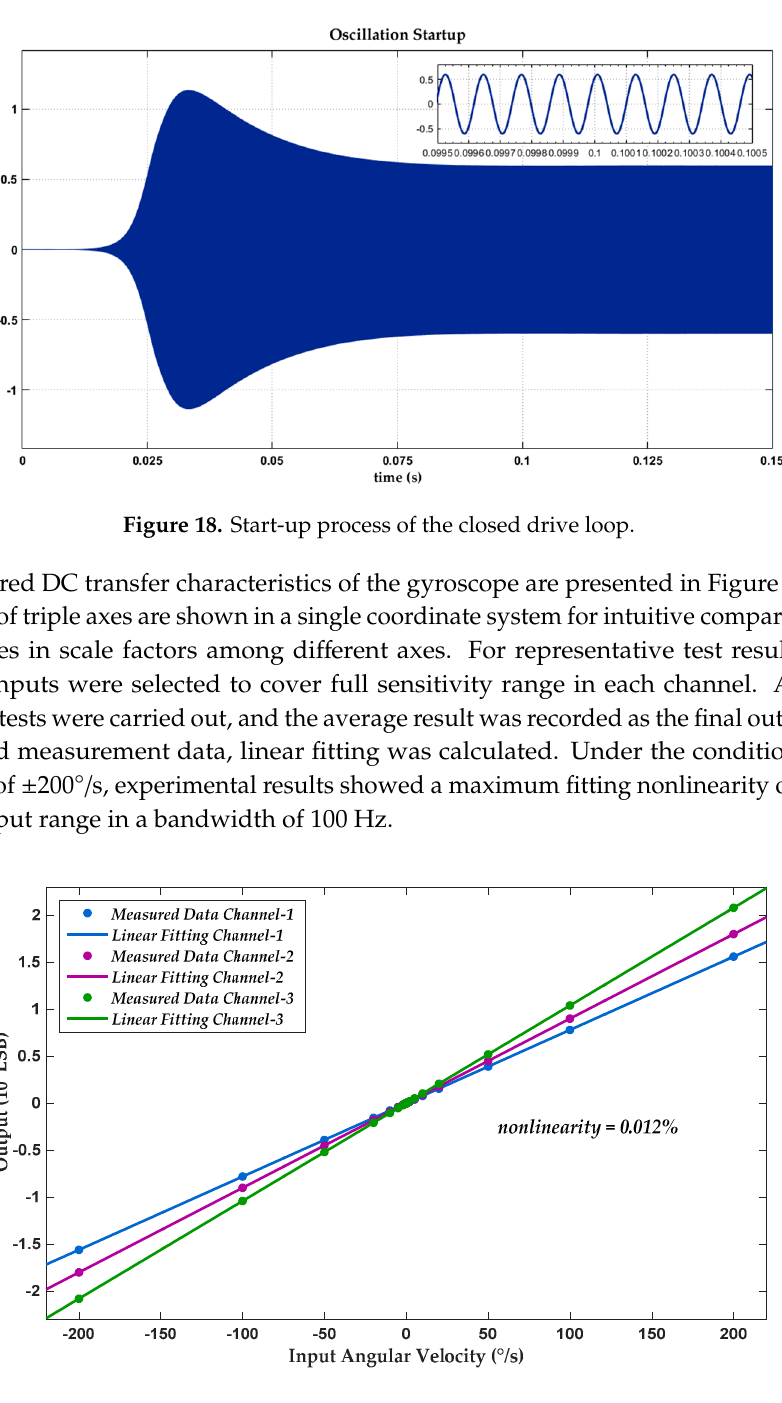
Figure 20. Measured noise floor of the proposed gyroscope ASIC. The prototype gyroscope was tested on a settled rate table in a thermostat for exclusion of environmental disturbance on comprehensive performances. Under the condition of preset